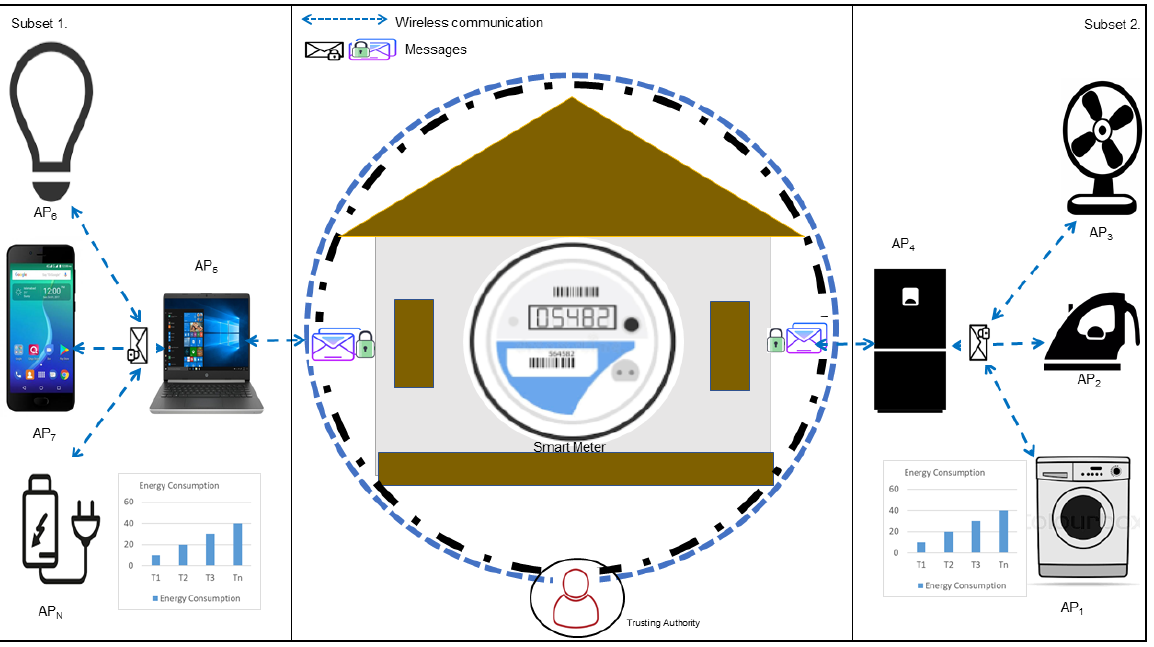
Figure 1. A home area